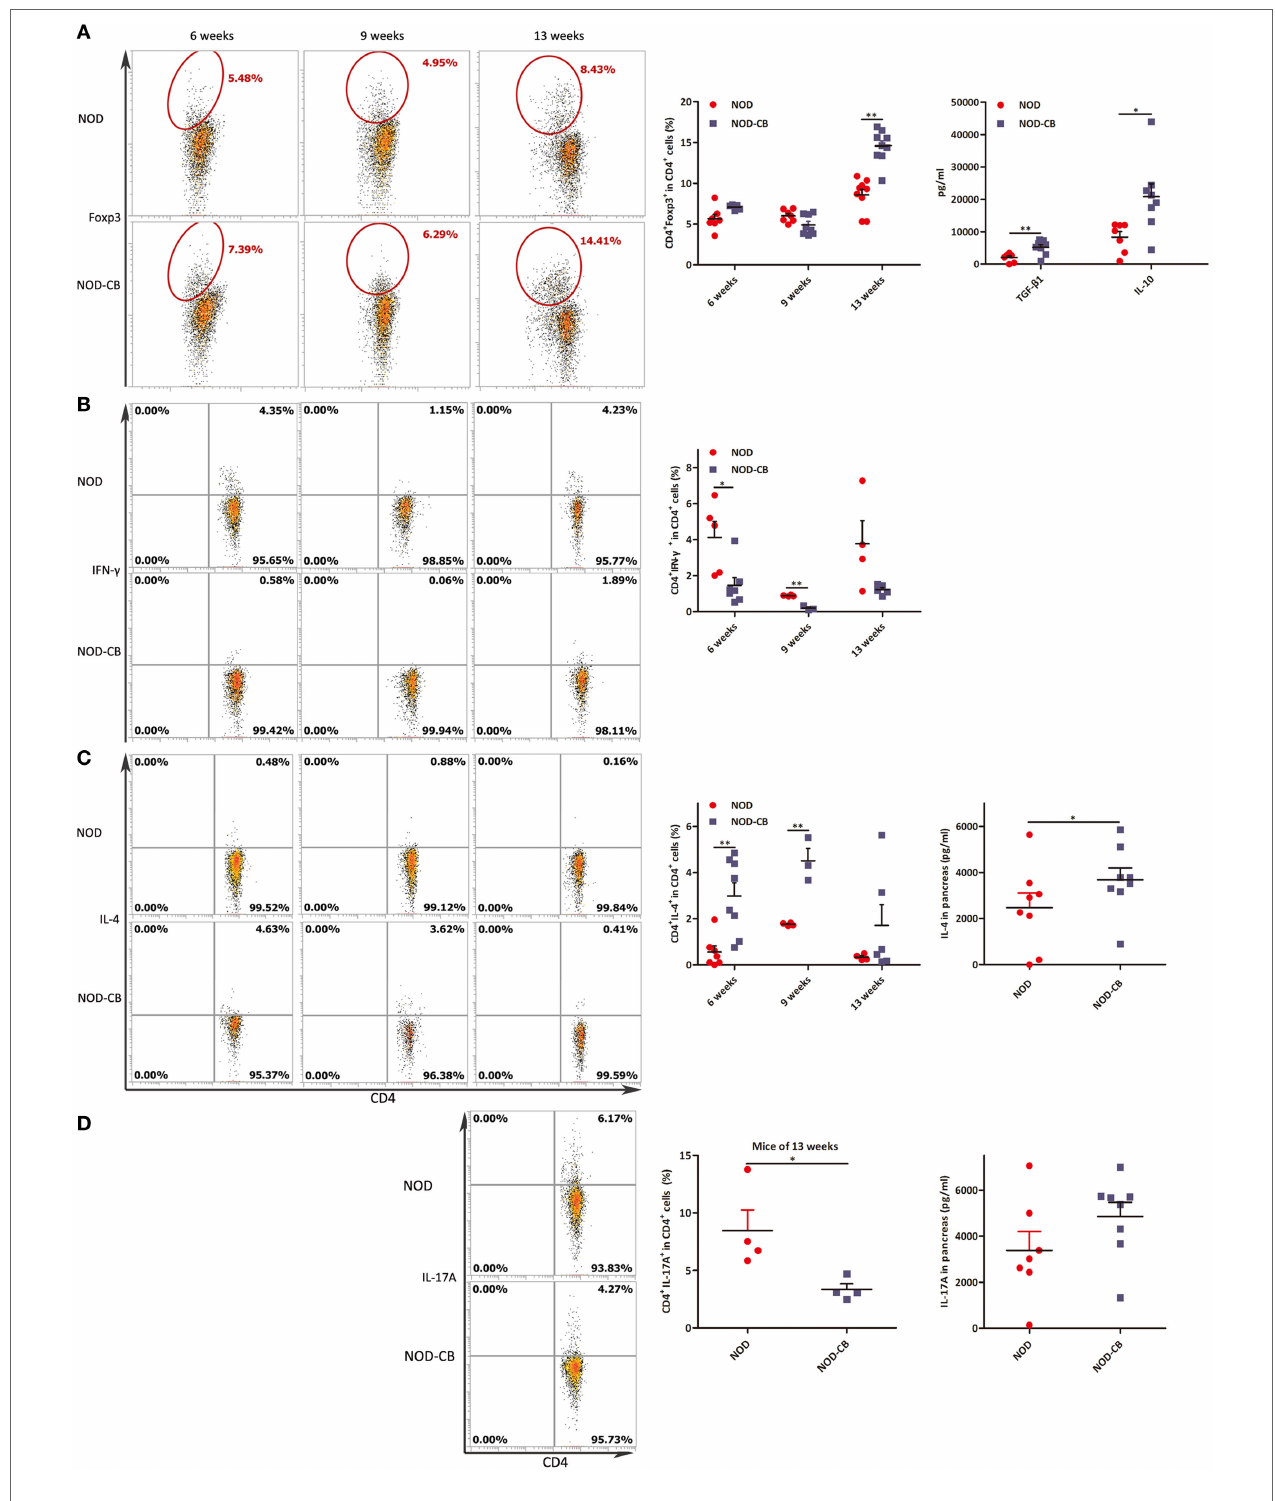
FigUre 8 | CB0313.1 induces pancreatic Tregs and reduces pancreas inflammation. (a) Percent CD4 + Foxp3 + cells in pancreas as indicated at 6, 9, and 13 weeks of age, and protein levels of TGF- β , IL-10 determined by ELISA at 13 weeks of age. (B) Percent CD4 + IFN- γ + cells in pancreas as indicated at 6, 9, and 13 weeks of age. (c) CD4 + IL-4 + cells in pancreas as indicated at 6, 9, and 13 weeks of age, and protein level of IL-4 determined by ELISA at 13 weeks of age. (D) CD4 + IL-17A + in pancreas as indicated at 13 weeks of age, and protein level of IL-17A determined by ELISA at 13 weeks of age. Data are mean ± SEM ( n = 4–15 mice per group). *, **, *** p < 0.05, p < 0.01, p < 0.001 vs NOD control mice by t -test. For (a) , the number of cells is 5,000. For (B–D) , the number of cells is